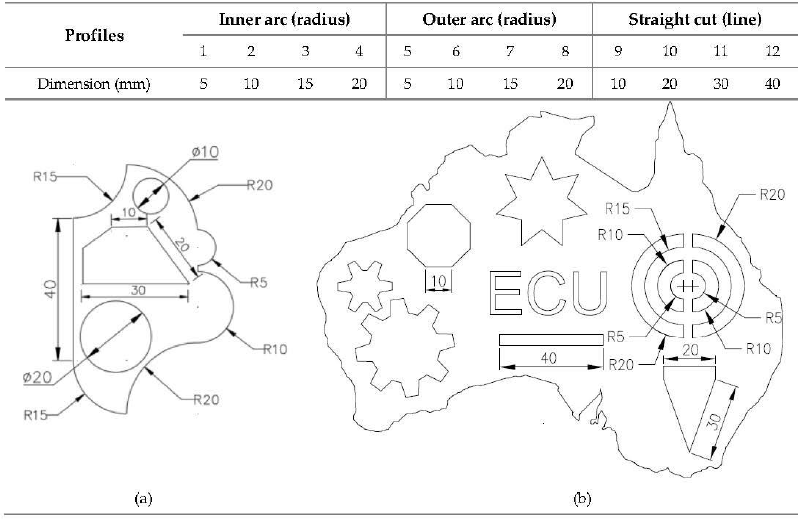
Figure 2. AWJM contour cutting path for ( a ) Taguchi L₂₇ tests [32]. ( b ) Confirmation